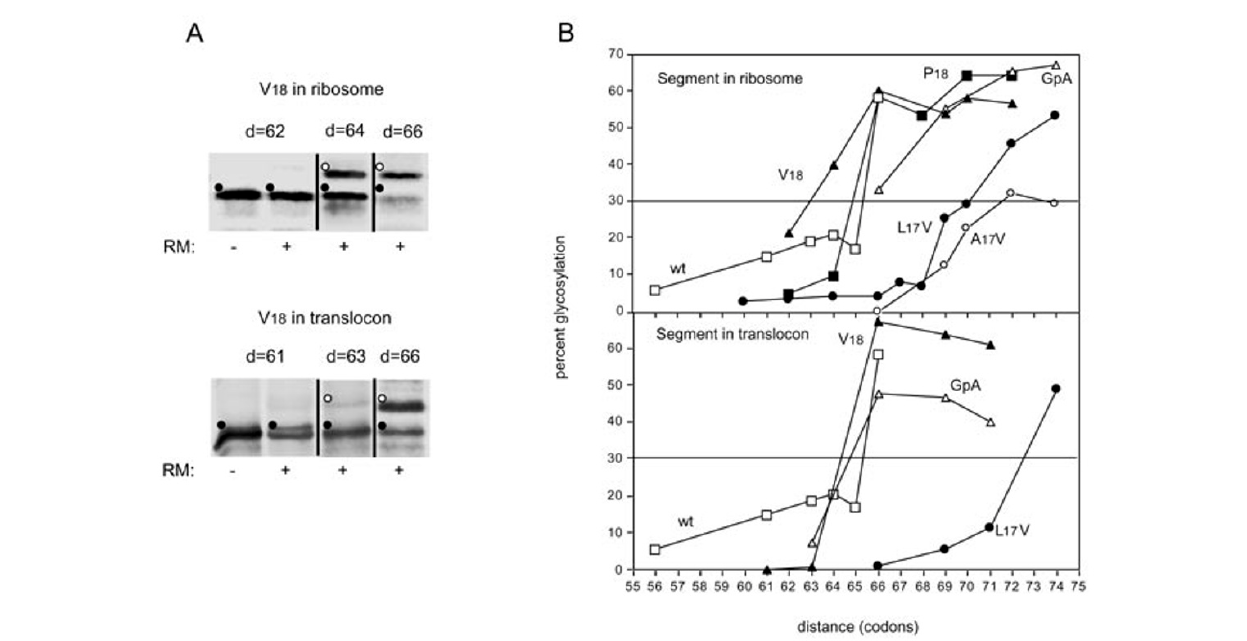
Figure 2 Determination of d P-O values for constructs where a model polypeptide segment has been inserted into the middle of the C- terminal P2 domain of Lep. (A) Two constructs with a ...QQQV 18 KKKK... model segment in the C-terminal domain were trans- lated in vitro in the absence (-) and presence (+) of rough dog pancreas microsomes (RM). The 3' codon in the truncated mRNA was placed d codons downstream of the Asn residue in the Asn-Ser-Thr glycosylation acceptor site. The Asn residue in the acceptor site was placed in lep codon 178 (upper panel) or 200 (lower panel), and the model segment was inserted between lep codons 214 and 220 in both constructs. For the indicated range of d values, the model segment is located in the ribosome (upper panel) or in the translocon (lower panel). Non-glycosylated and glycosylated molecules are indicated by black and white dots, respectively. (B) Glycosylation profiles for constructs with model segments composed of the indicated residues flanked by QQQ....KKKK. The Asn residue in the acceptor site was placed in lep codon 178 (upper panel) or 200 (lower panel), and the model segment was inserted between lep codons 214 and 220 in all constructs. Half-maximal glycosylation (30%) is indicated by the horizontal